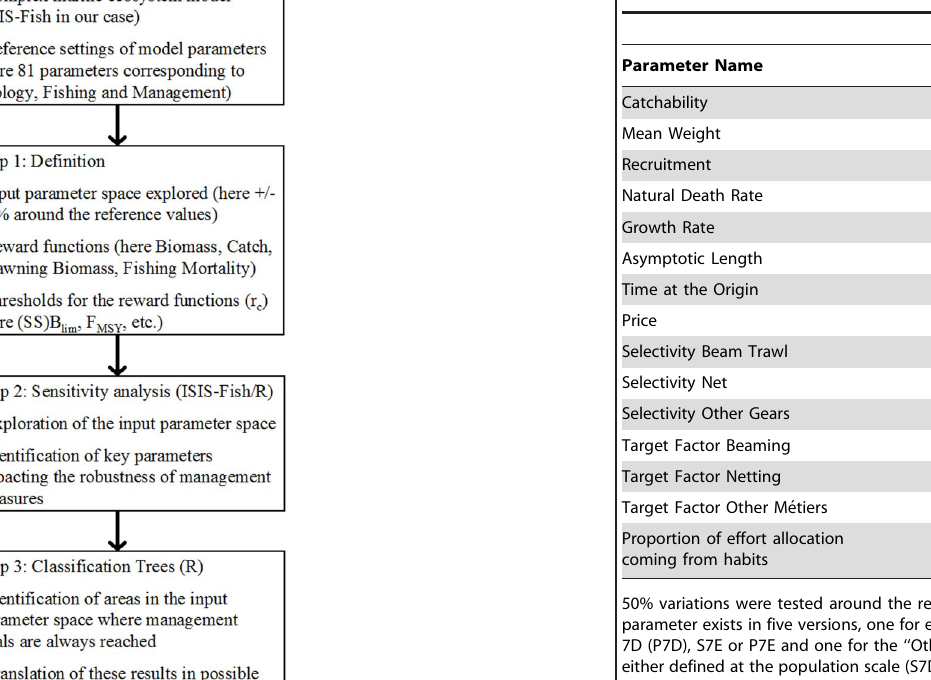
Table 3. Biological and technical parameters tested, for every population, me´tier or gear.